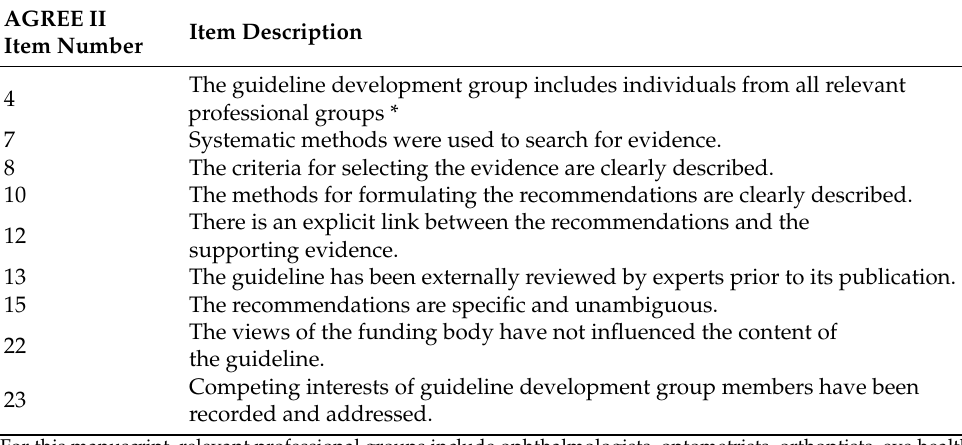
Table 2. AGREE II tool items used for the selection of Clinical Practice Guidelines